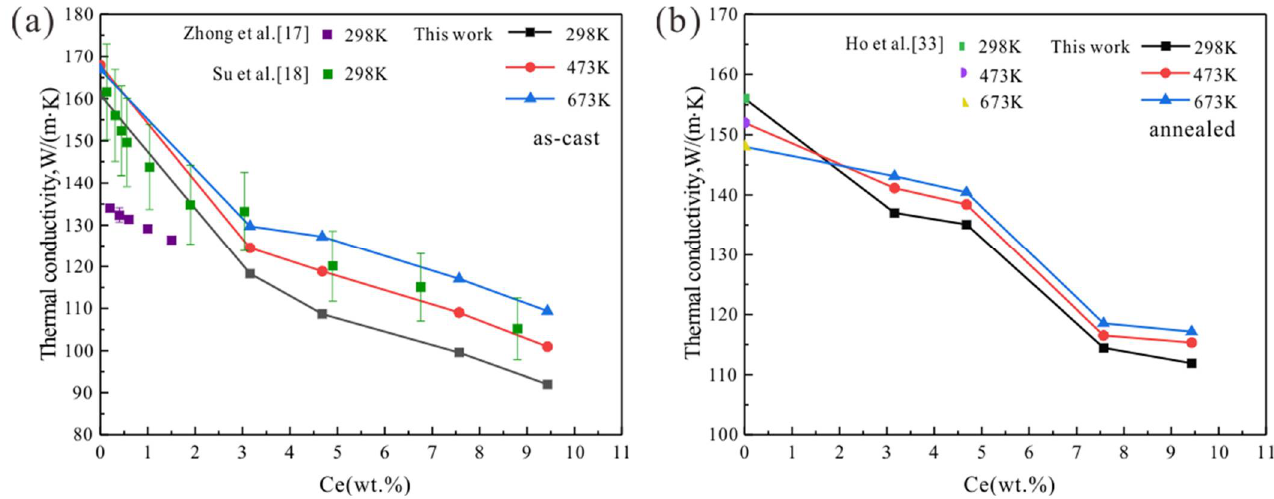
Figure 5. Thermal conductivity of ( a ) as-cast Mg-Ce alloys; ( b ) annealed Mg-Ce alloys.